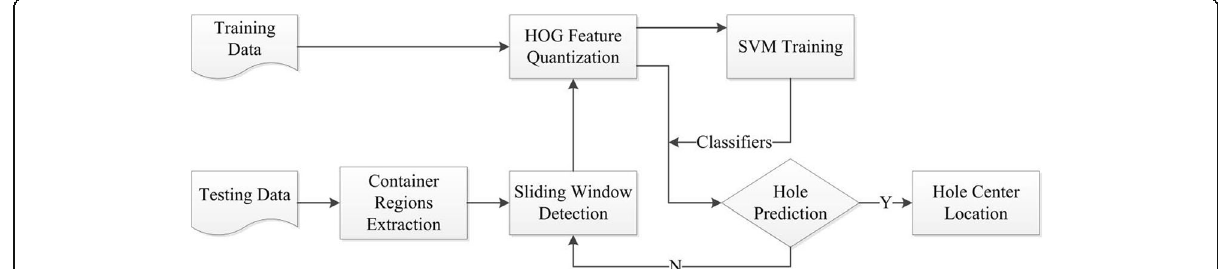
Fig. 1 Overall framework of the proposed